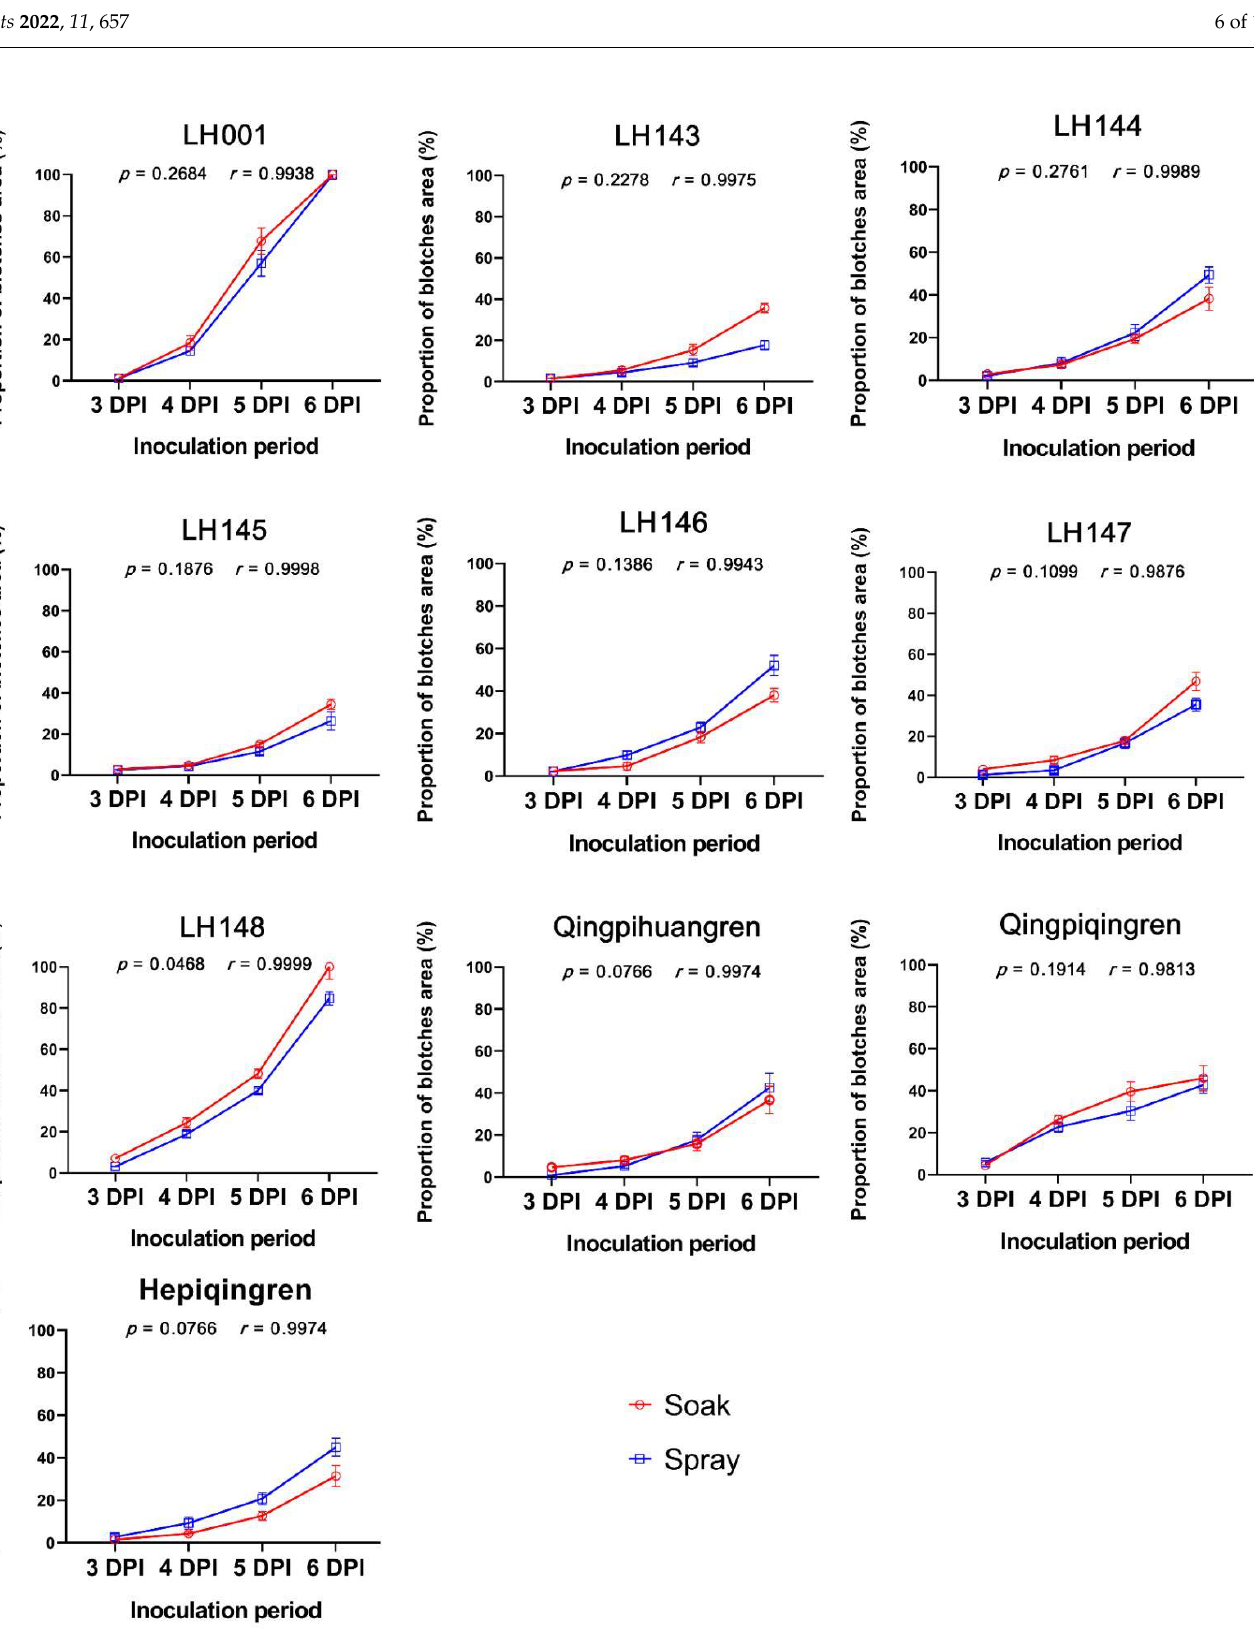
Figure 5. Proportion of the pod surface area covered by blotches 3 to 6 days after inoculation of the pods from 10 soybean accessions with the mycelial suspensions, administered by soaking or spraying. In each plot, the correlation coefficient ( r ) and the significance of differences ( p -value) between the two methods are shown for each accession.